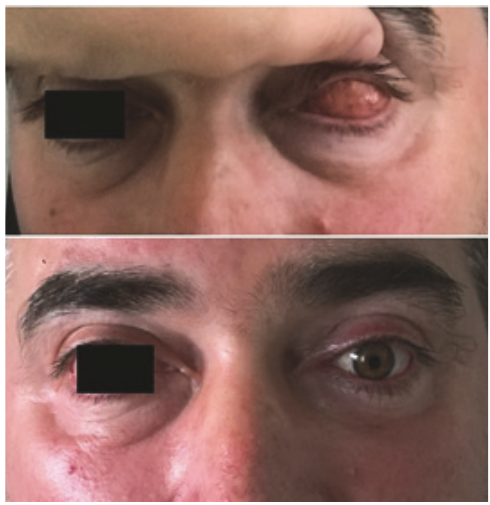
Figure 2: 44-year-old Caucasian male patient 8 months after the